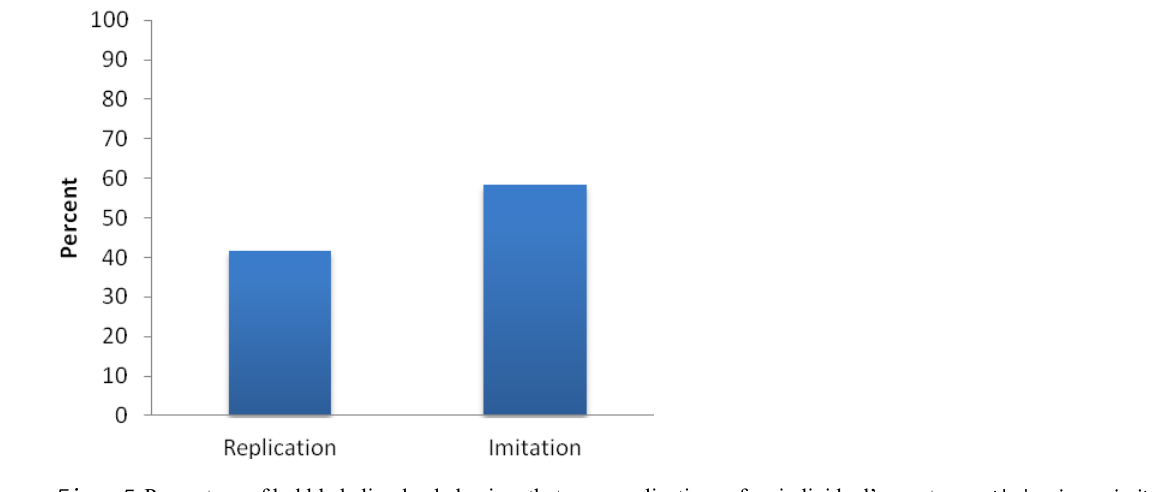
Figure 5. Percentage of bubble helix play behaviors that were replications of an individual’s most recent behavior or imitations of another’s previous behavior.